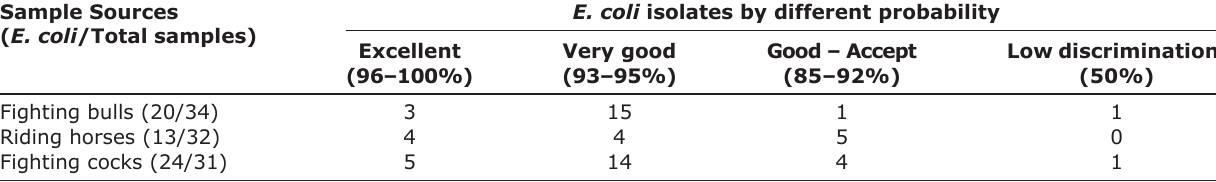
Table-2: Escherichia coli from sport animal identified by Vitek 2 ® Compact. Sample Sources ( E. coli /Total samples)